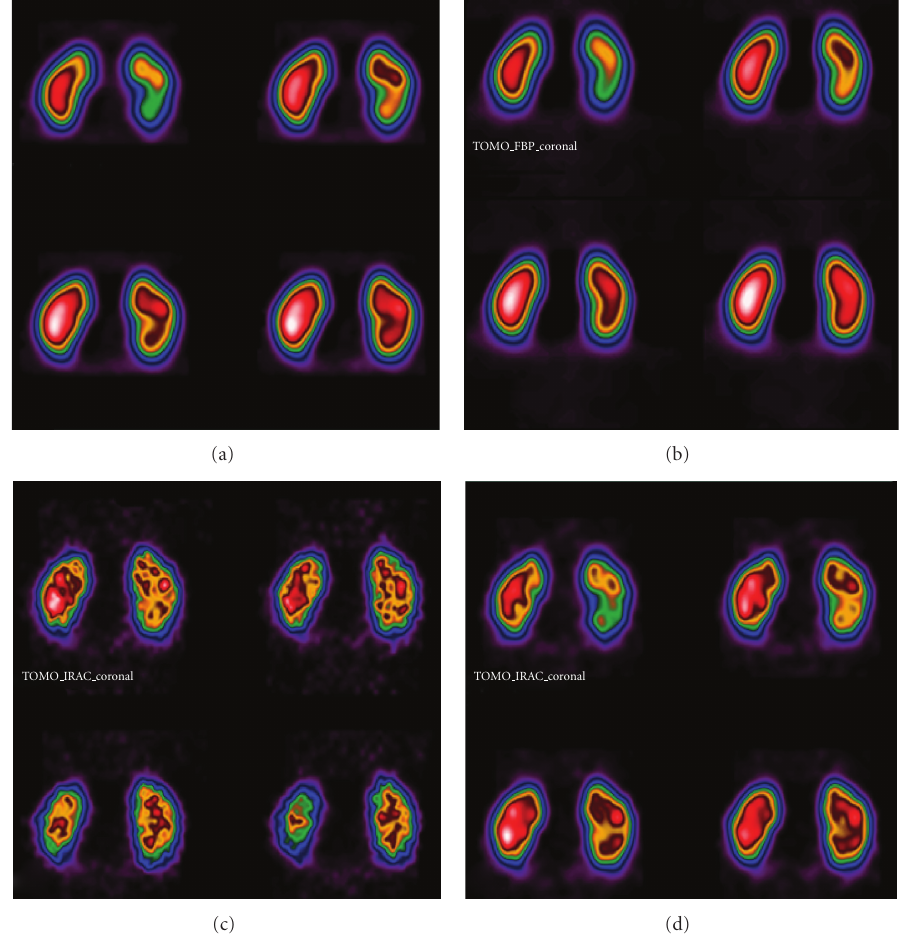
Figure 14: Coronal slices of renal SPECT study. The e ff ect of filtering in smoothing and contrast of SPECT reconstruction, by FBP and Chang attenuation correction (coe ffi cient 0.11) or OSEM iterations is reflected on clinical images. (a) FBP reconstruction, Butterworth filter (critical frequency 0.5cm − 1 , power 10) (b) FBP reconstruction, Hann filter (critical frequency 0.9cm − 1 ) (c) OSEM 10 subsets/10 iterations (d) OSEM 10 subsets/10 iterations and postfiltering by Butterworth (critical frequency 0.5 cm − 1 , power 10). Study has been completed in Radiation Physics Unit, Department of Radiology, University of